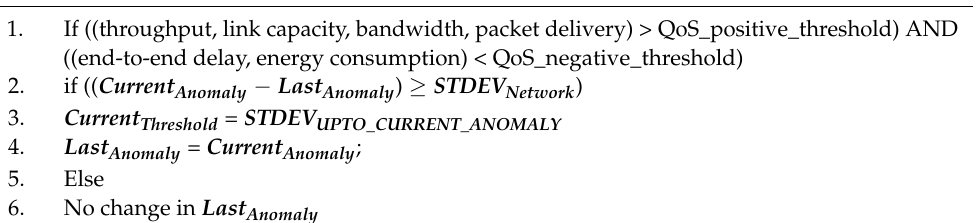
Algorithm 2: Threshold limit for a local event if a link is BUSY